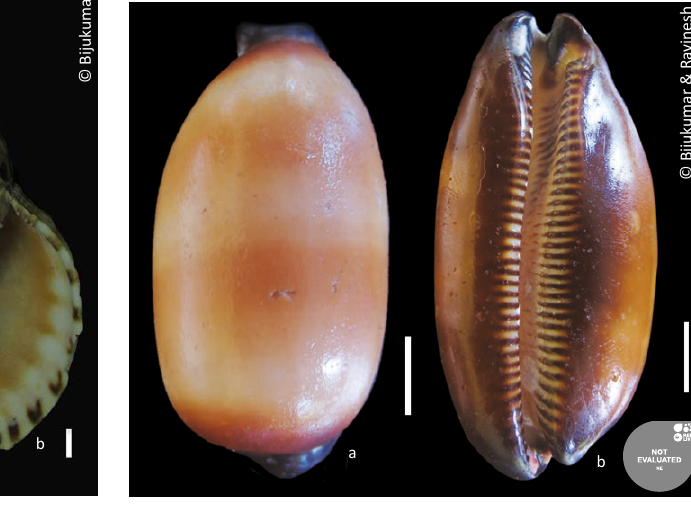
Image 8. Charonia tritonis Linnaeus a - dorsal view; b - ventral view (scale = 1 cm)